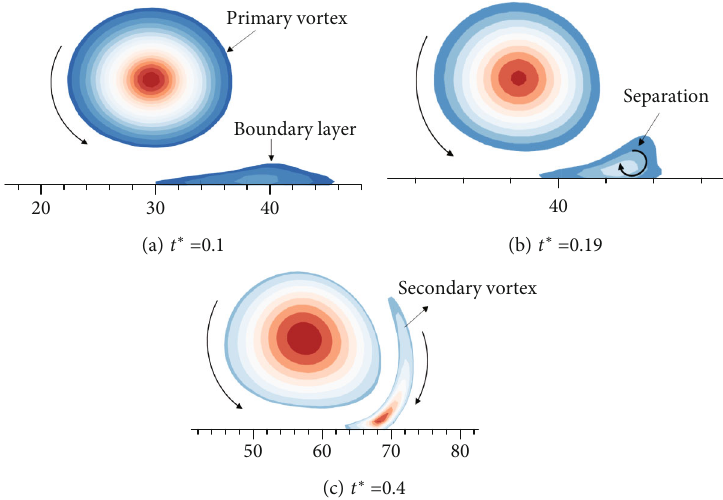
Figure 8: Generation of the secondary vortex and rebound of the main